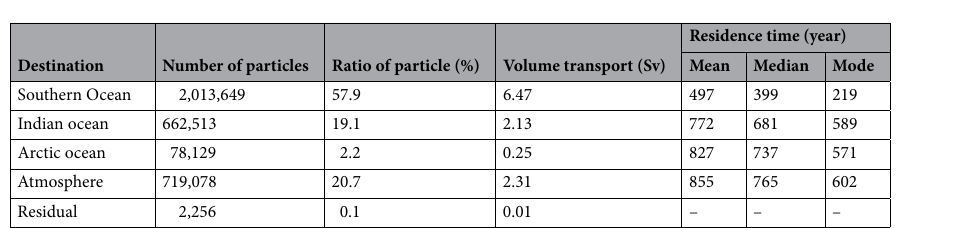
Table 2. Same as Table 1 but for the case 1D. The total number of particles is 3,475,625.